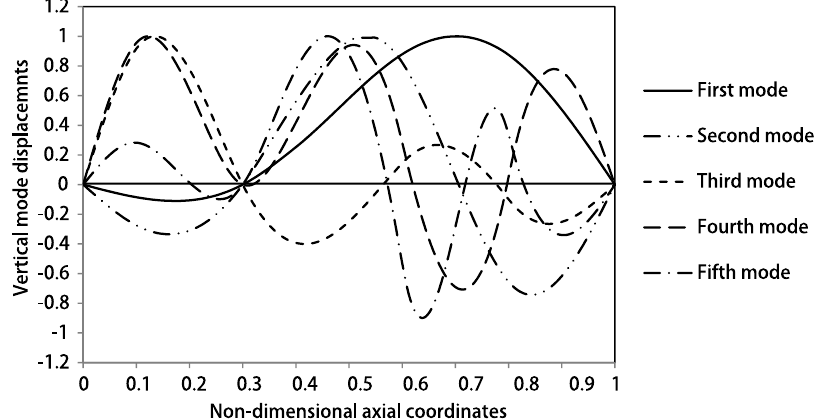
Fig. 4. The lowest five mode shapes of a single-span uniform beam carrying three point masses, two rotary inertias, two linear springs, two rotational springs and subjected to axial load.